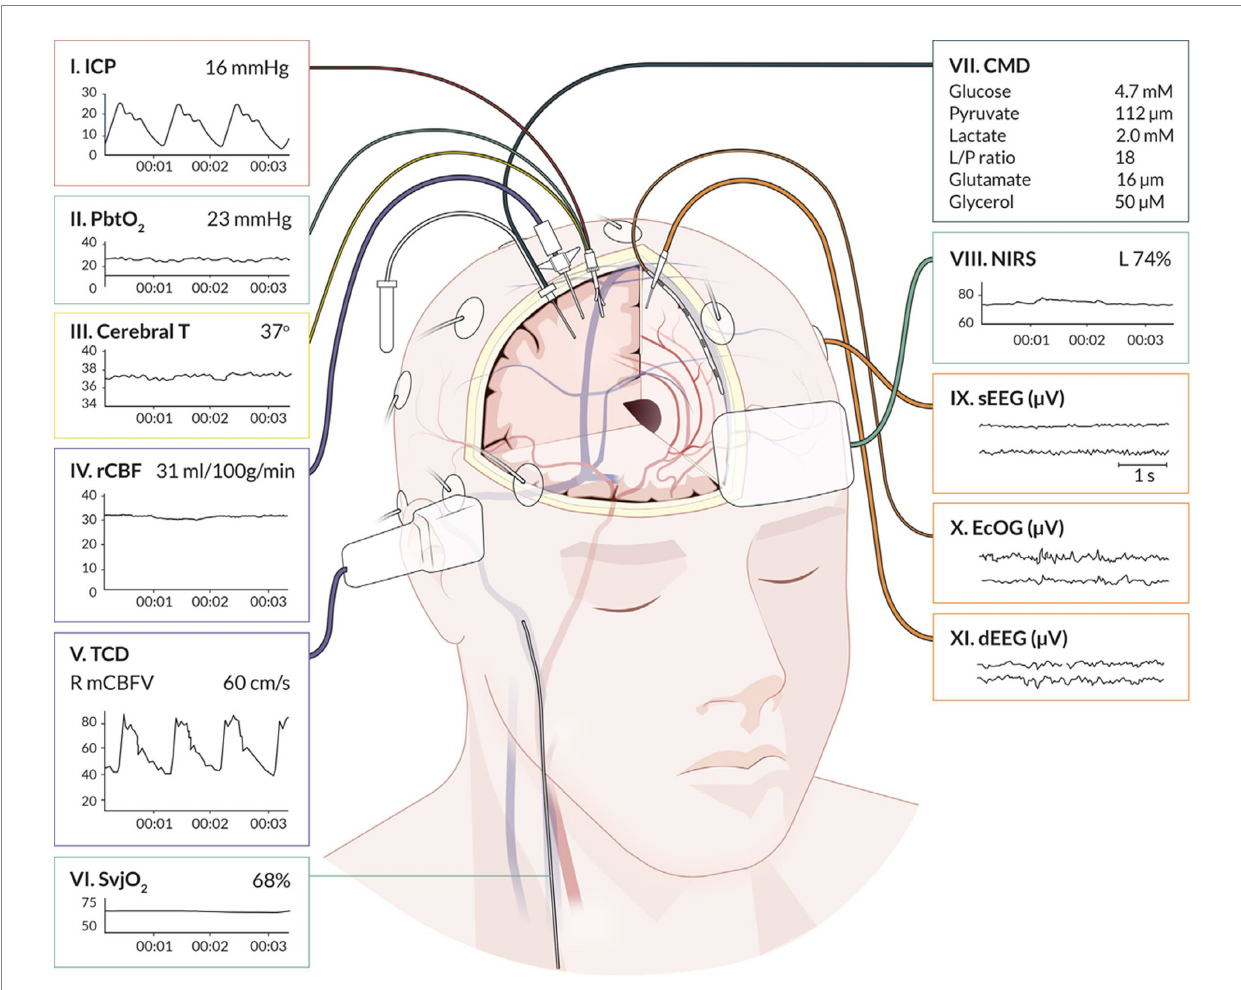
FIGURE 1 Graphical representation of cerebral multimodality monitoring modalities. Cerebral T, cerebral temperature; CMD, cerebral microdialysis; dEEG, depth electroencephalography; ECoG, electrocorticography; ICP, intracranial pressure; NIRS, near-infrared spectroscopy; PbtO 2 , partial pressure of brain tissue oxygenation; rCBF, regional cerebral blood flow; sEEG, surface electroencephalography; SvjO 2 , jugular bulb venous oximetry; TCD, transcranial Doppler. Reprinted with permission from open access publication corresponding author, Tas and colleagues (4). Professional illustration by Anna Sieben (Sieben Medical